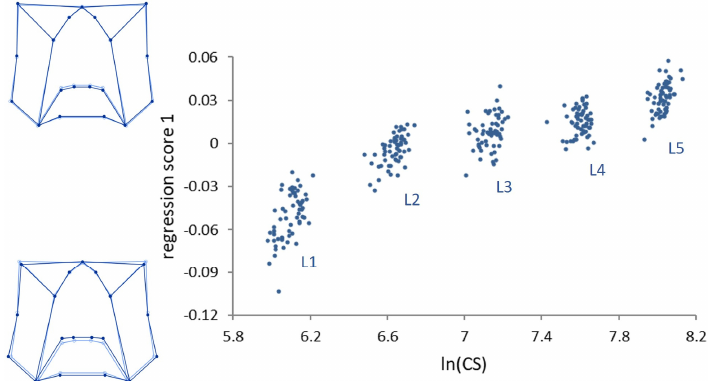
Figure 3. Multivariate regression of shape on size ( lnCS ) during the five larval stages in P. brassicae . Dark blue wireframes show the pattern of shape variation along the vertical axis with respect to the average shape (light blue wireframes).